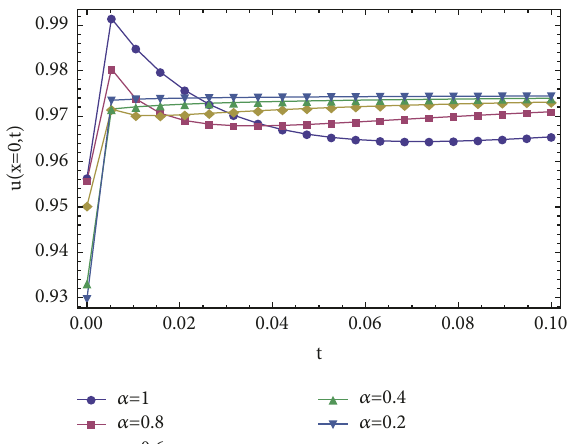
Figure 1: Plot of 𝑢(𝑥 = 0, 𝑡) for various values of 𝛼 .